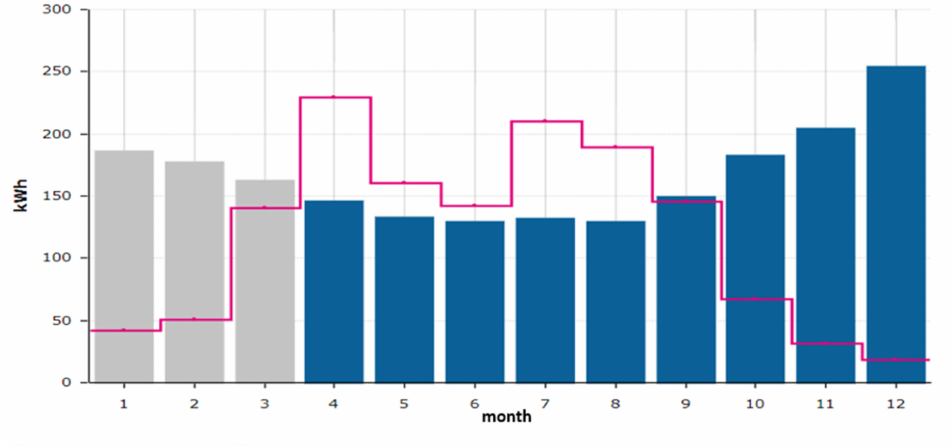
Figure 9. Diagram of energy consumed and fed into the grid from a home installation adjusted to the demand in 2020. Source: own